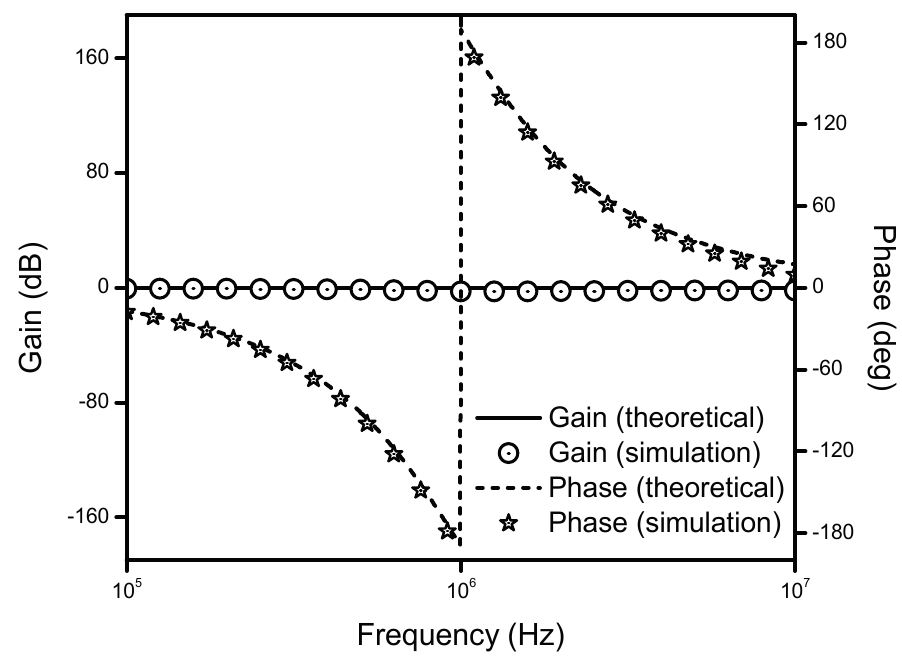
Figure 13. Frequency responses of the allpass function in Figure